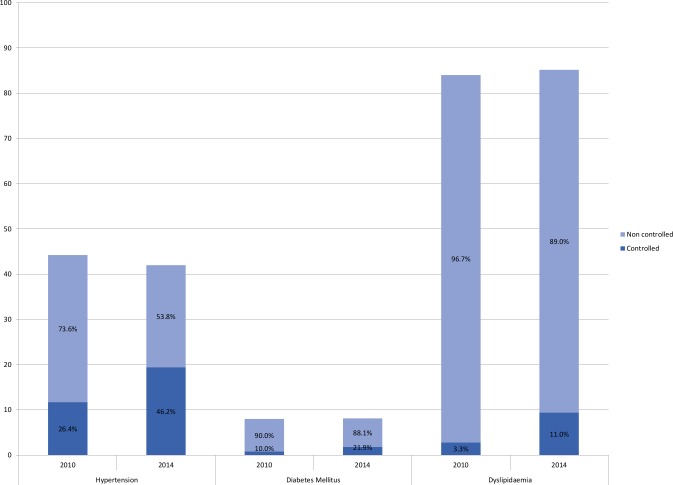
Cardiovascular risk factors prevalence and control for the period studied.Each bar shows the total prevalence of disease in the year indicated. Percentages in each bar correspond to the proportion of subjects controlled and non-controlled of all those diagnosed.